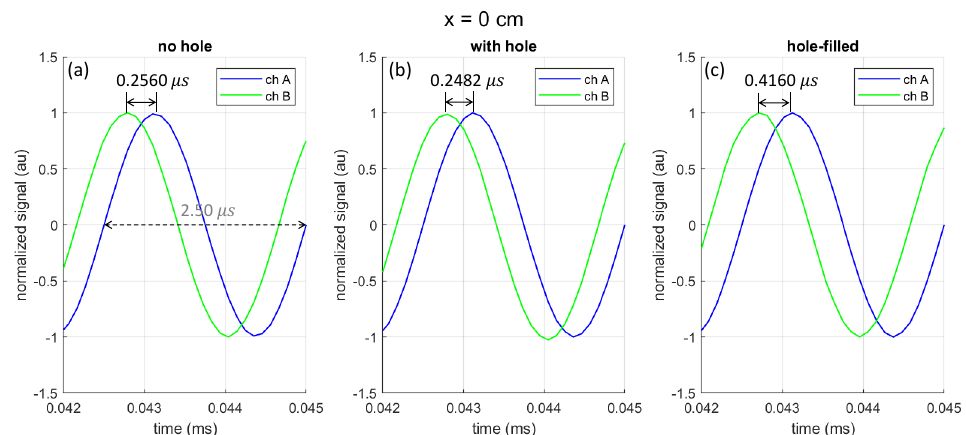
Figure 11. Time domain signal observed in channel A and channel B. ( a ) no hole centered; ( b ) hole centered; ( c ) hole–filled centered